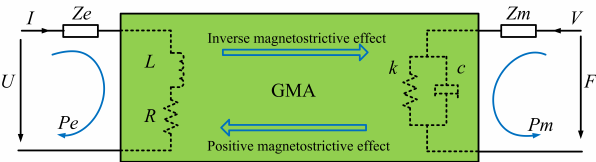
Figure 1. Double-terminal network energy transfer model of a giant magnetostrictive actuator